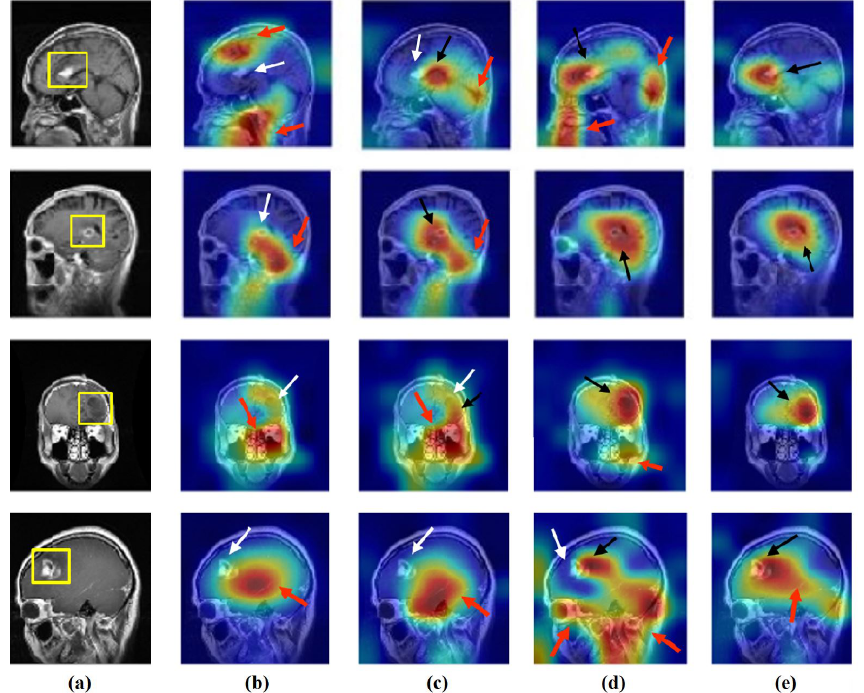
Figure 16. Visualisation of deep features for class glioma of brain tumour test set images obtained by each model: ( a ) original image, ( b ) ResNet-50 pre-trained network, ( c ) DeTraC, ( d ) 4S-DT , and ( e ) XDecompo .